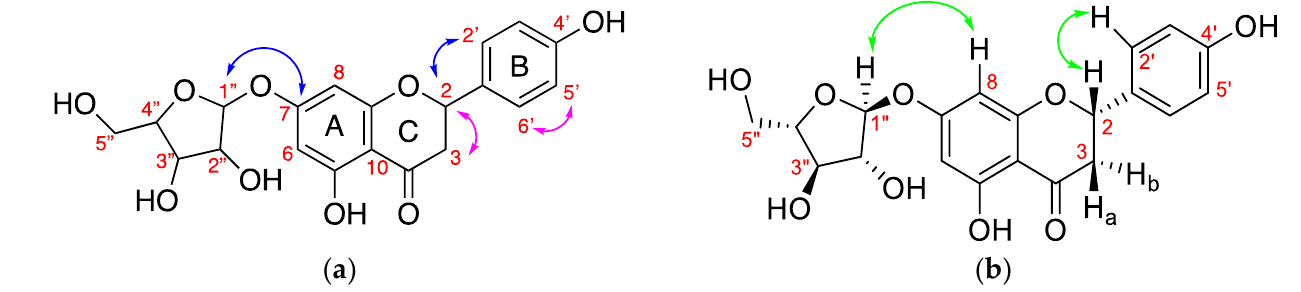
Figure 4. ( a ) key COSY ( ↔ ) proton-to-proton connection and HMBC ( ↔ ) correlation, ( b ) NOESY ( ↔ ) information of naringenin-7-O- α - L -arabinopyranoside 2 . 13 C NMR signals of the sugar moiety are similar to those reported for arabinopyra- noside structure by Zhang et al. [30 ]. The anomeric proton of δ 4.694 ppm (d, J = 7.48 Hz,